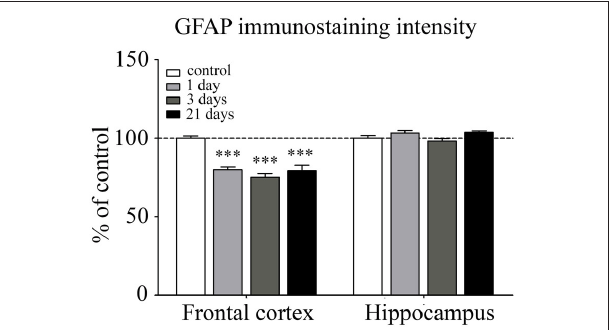
FIGURE 8 | Effect of restraint stress on GFAP immunostaining associated with brain capillaries in the rat frontal cortex and hippocampus. GFAP was immunostained on brain sections of control and stressed rats. Green color: immunostaining for GFAP. Blue color: cell nuclei stained with Hoechst dye 33342. Scale bar: 15 µ m.